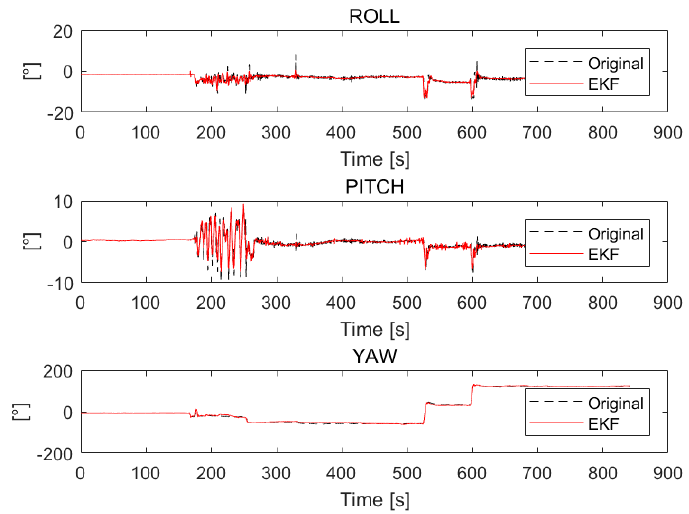
Figure 8. The original roll, pitch, and yaw value and the filtering result of EKF. The upper plot is the filtering result of the roll angle; the middle plot is the filtering result of the pitch angle, and the lower plot is the filtering result of the yaw angle.